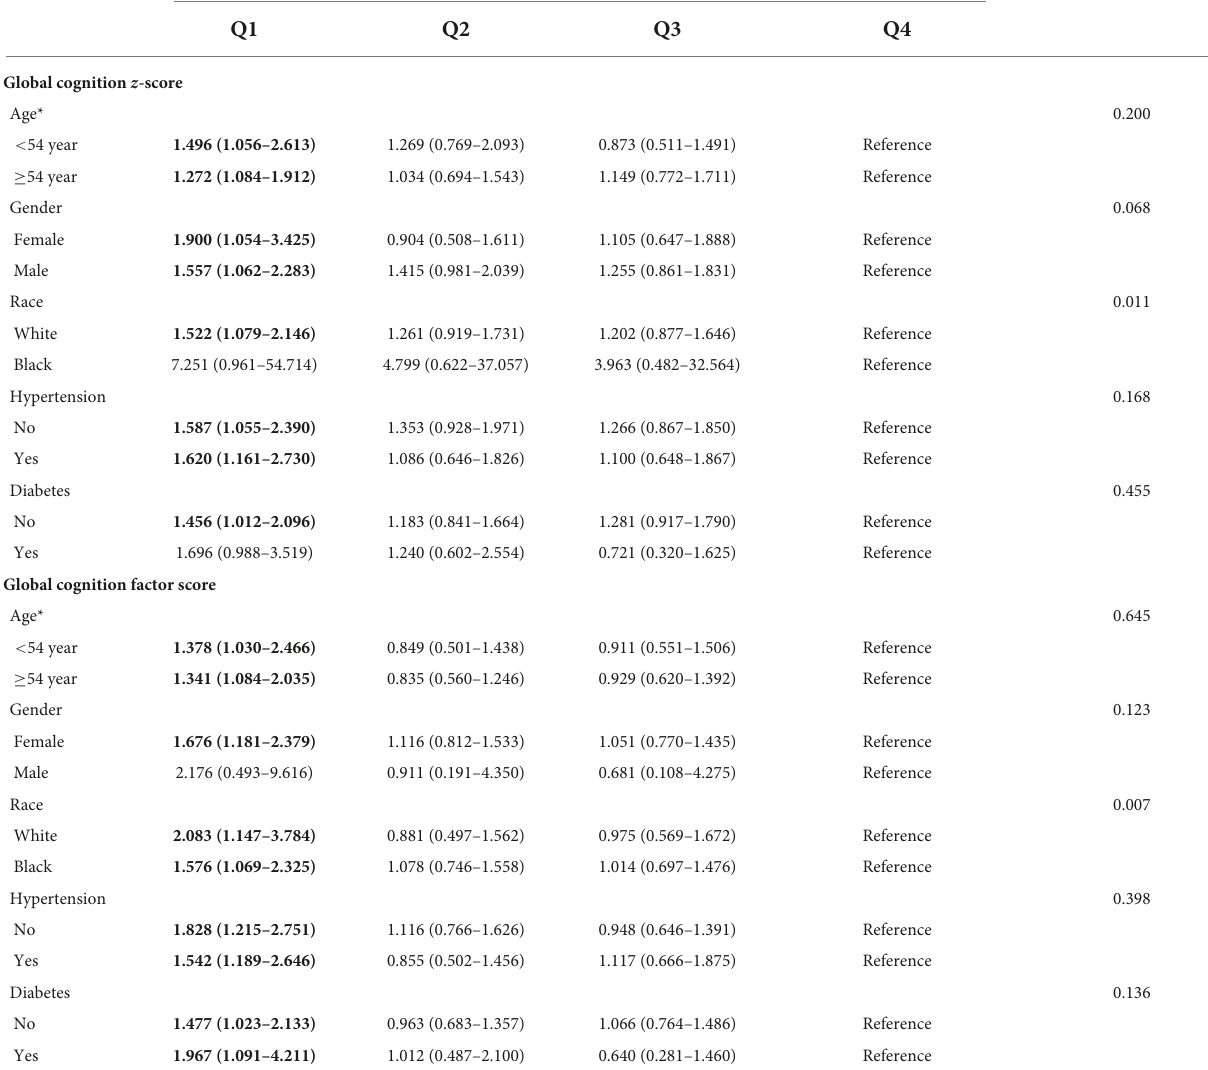
TABLE 3 Adjusted ORs (95% CIs) for the association of baseline (1991–1993) cognition function with incident elevated hs-cTnT in different subgroups.